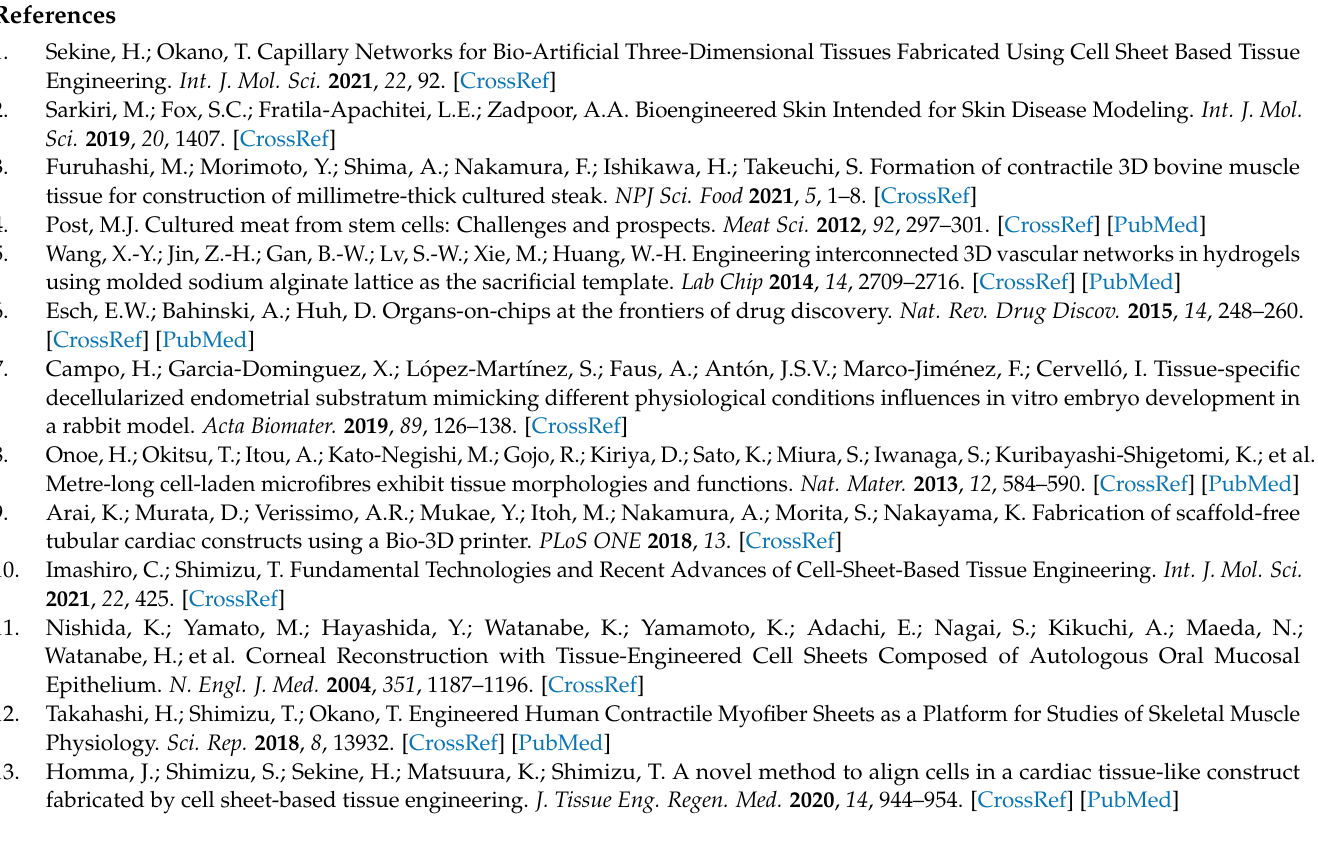
Figure A3. The schematic image shows the evaluation methods for shear stress from the media flow (left upper side) and the tensile deformation due to the leaky flow toward the bottom of the tissue.